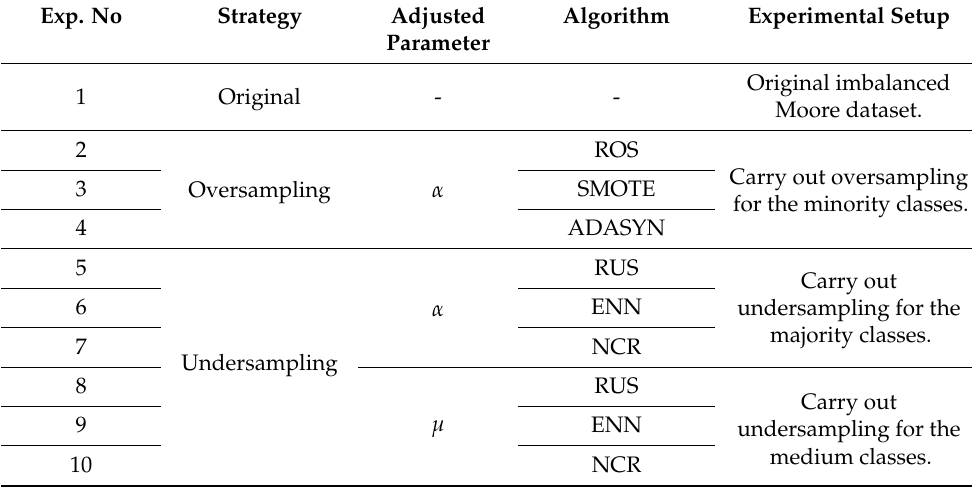
Table 8. Experimental setup and